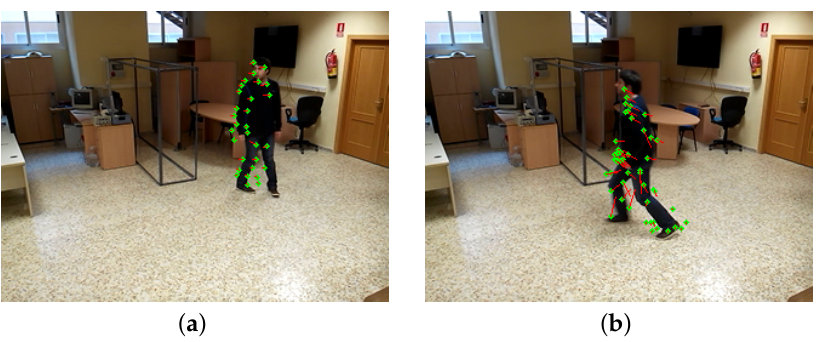
Figure 8. Optical flow applied to the subject in a scene. ( a ) Subject rotating. ( b ) Subject getting up after a fall